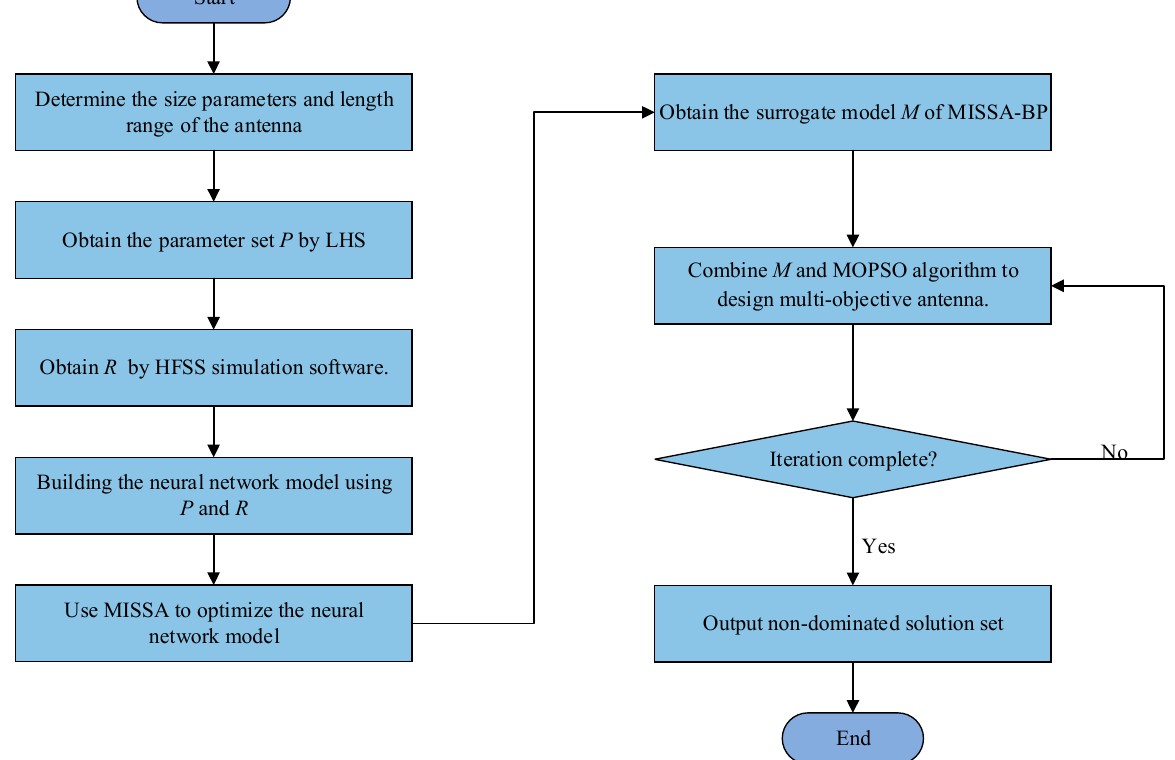
Figure 6. Flow chart of antenna design based on MISSA-BP.